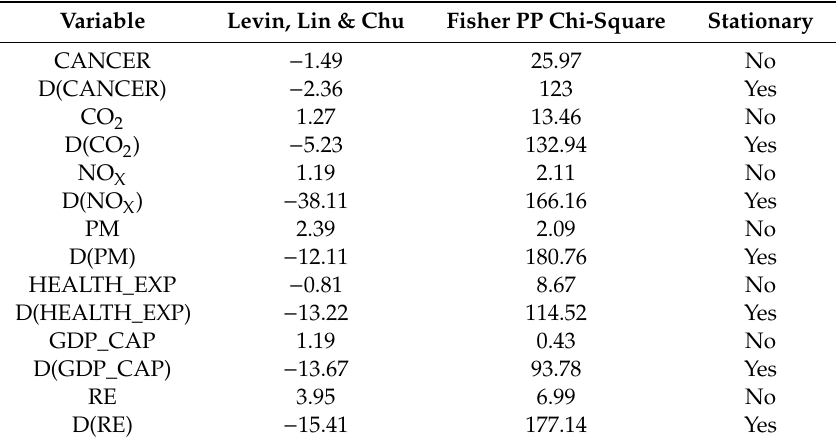
Table 3. Robustness check for panel unit root test